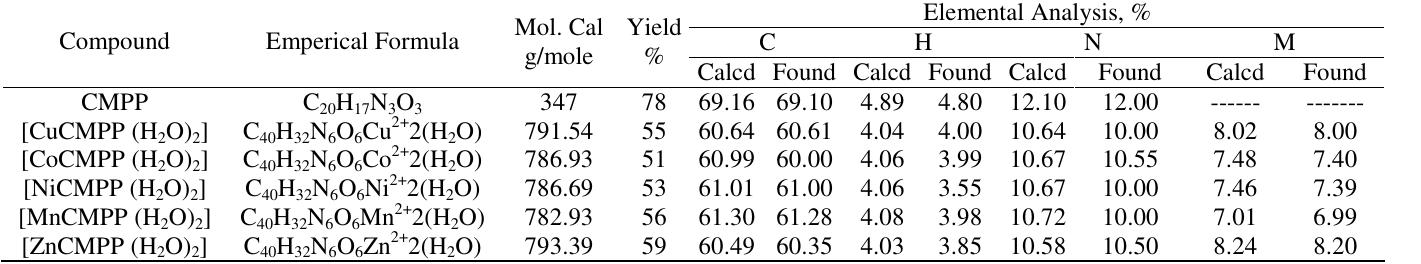
Table 1. Analytical data of the metal chelates of